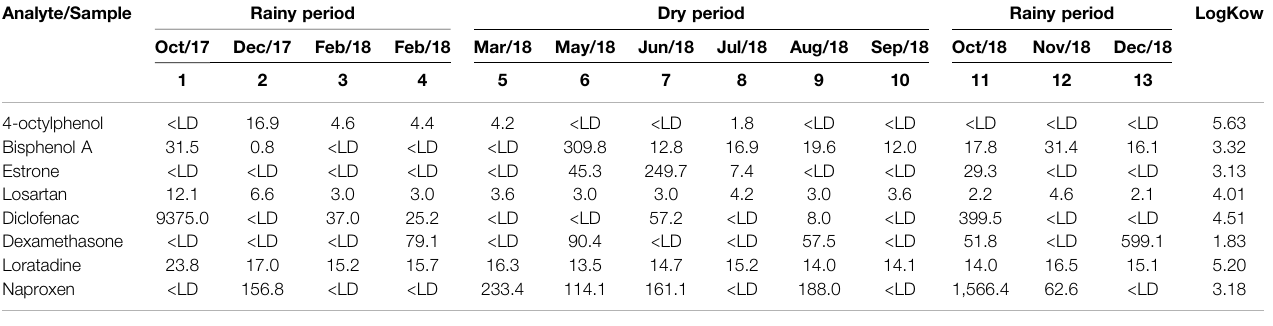
TABLE 6 | Values of concentrations (ng L − 1 ) of pharmaceuticals and endocrine disruptors which occurred in the fi lter washing water (FWW) of WTP-Jataizinho with a minimum frequency of 30%. Analyte/Sample Rainy period